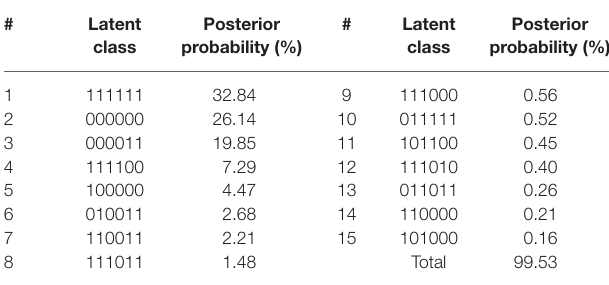
TABLE 7 | Latent classes and posterior